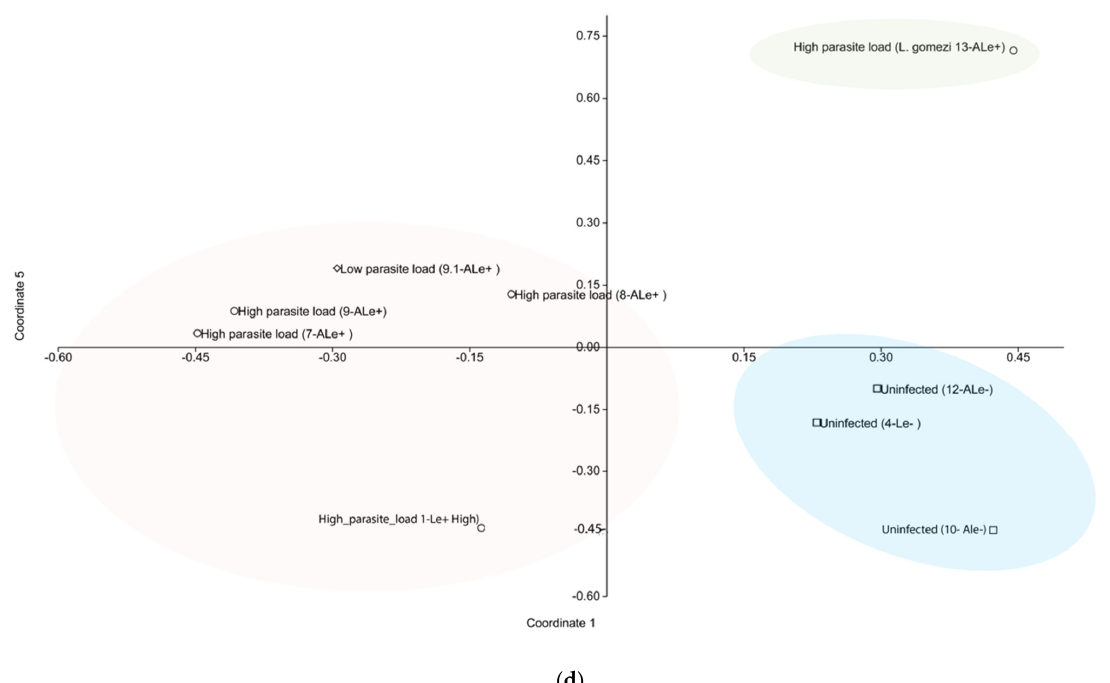
Figure 2. Gut microbiota composition and diversity in wild specimens of P. evansi from the north of Colombia, infected with Leishmania and treated with antibiotics. ( a ) Relative abundance of ASVs that were called to the taxonomic rank of genus. Taxa with <0.5% relative abundance were grouped together as “Genus < 0.5%”. ( b ) α -Diversity index of ASVs of guts of P. evansi infected with Leishmania and treated with antibiotics. ( c ) Hierarchical clustering analysis ( β -diversity) of ASVs at the genus level ( d ) β -diversity analysis of microbial communities associated with the established groups of guts of P. evansi infected with Leishmania , using a Principal Coordinate Analysis (PCoA) of Bray–Curtis dissimilarities of 16S rRNA data, filtered as ASVs at the genus level. See Table 1 for the detailed nomenclature of P. evansi gut pools . Le + High, guts with high load of Leishmania and without antibiotics; Le - Uninfected, guts uninfected and without antibiotics; A Le + High-Low, guts with a high or low load of Leishmania and treated with antibiotics; A Le − Uninfected, guts uninfected but treated with antibiotics.